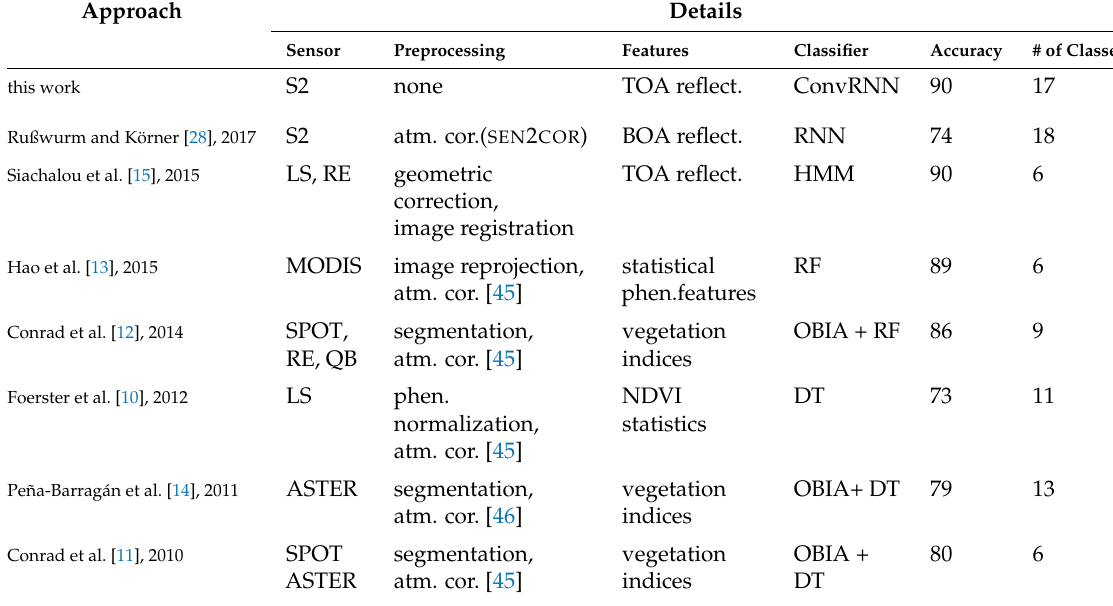
Table 3. Overview of recent approaches for crop